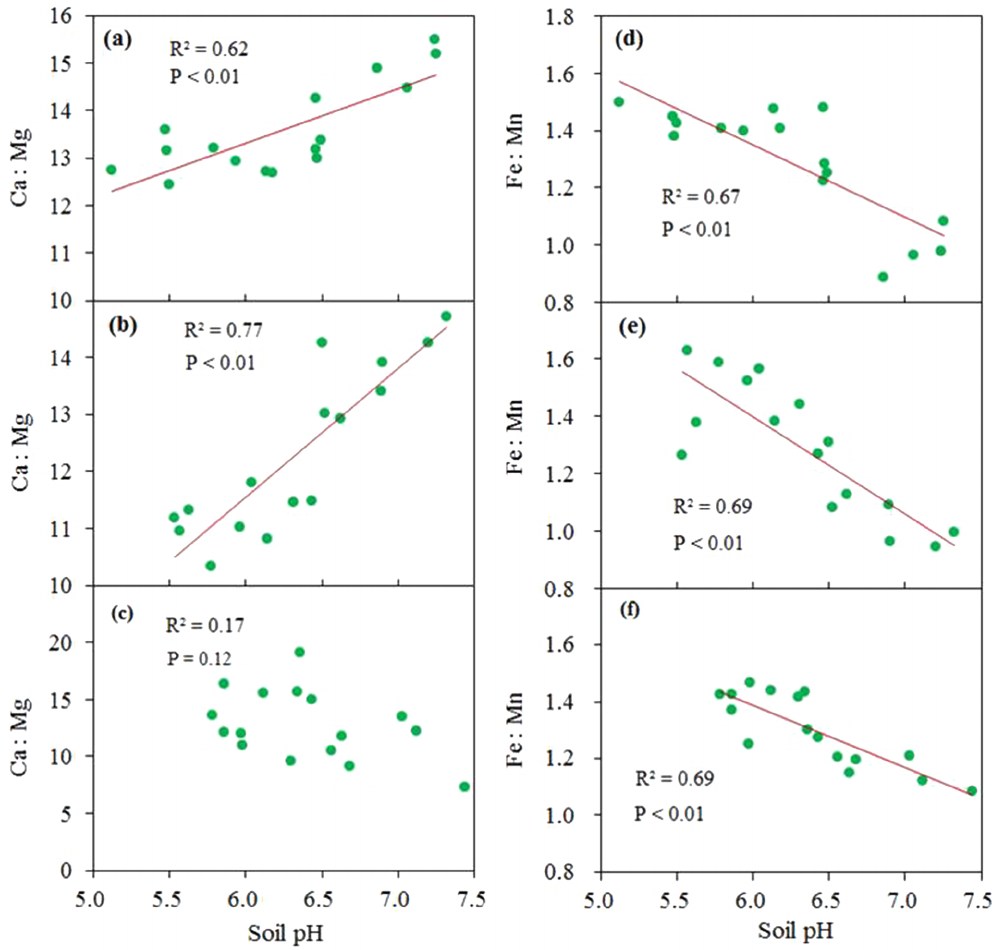
Figure 5. The relationships between soil pH and exchangeable Ca:Mg within large macroaggregates (a) , small macroaggregates (b) , and microaggregates (c) , and between soil pH and the available Fe:Mn ratio within large macroaggregates (d) , small macroaggregates (e) , and microaggregates (f) . The significance level was set at P